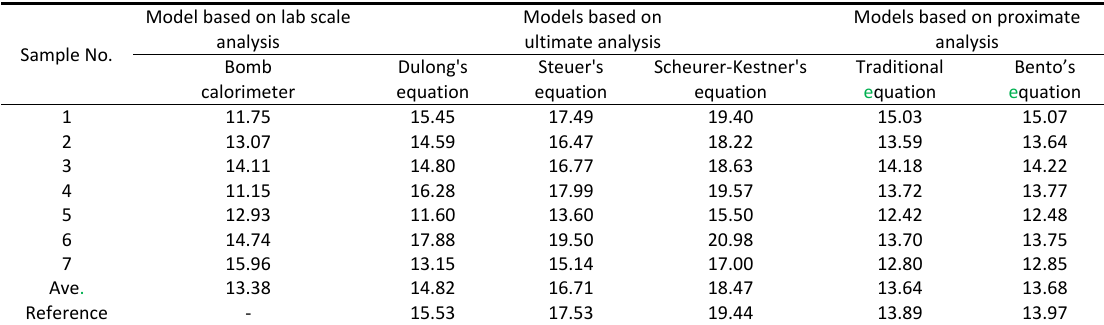
Table 7: LHV based on bomb calorimeter test (MJ/kg) compare to other models (dry basis) (Tchobanoglous et al ., 1993)